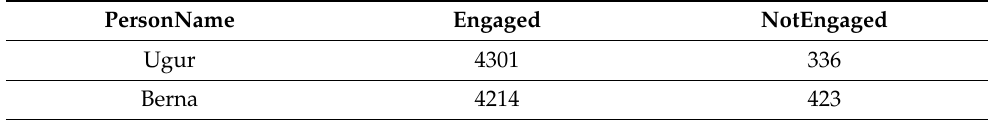
Table 1. SECS main module—student engagement classification results.